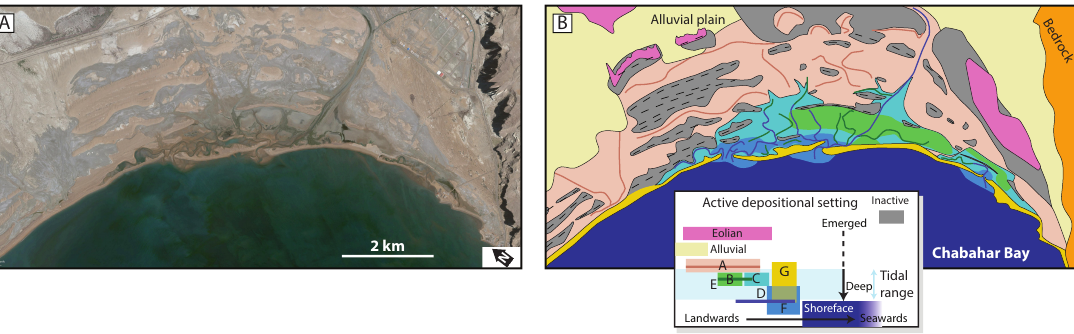
Figure 8. Chabahar Bay depositional setting. Facies lettering is as reported in Table 3. ( A ) Google Earth satellite image of the eastern part of Chabahar Bay (27 / 1 / 2015). N 25.42 ◦ , E 60.59 ◦ . ( B ) Interpretation of the described facies depositional environment. Black dashed lines: beach ridges. Colored full lines: tidal channels. Eolian degradation of inactive beach ridges is taking place but is di ffi cult to represent